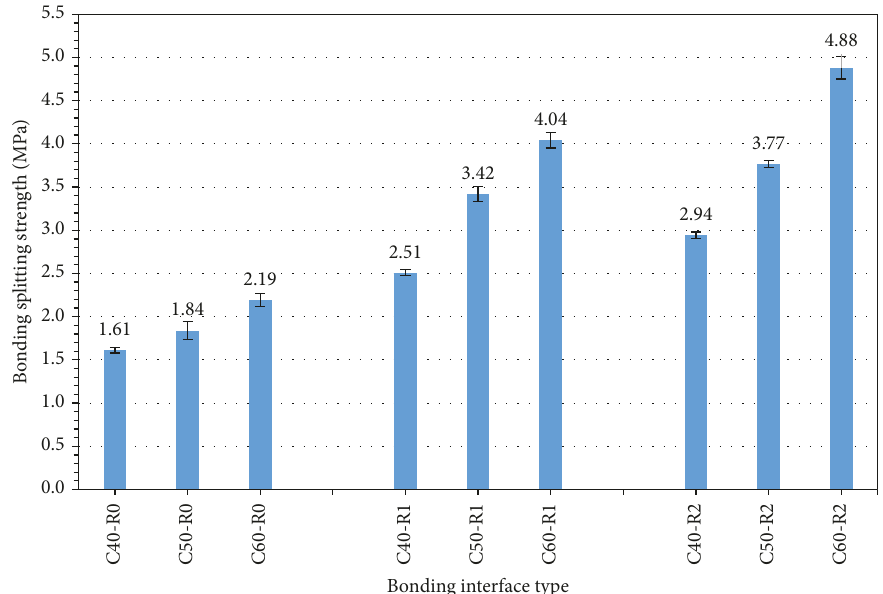
Figure 25: Bond splitting strength with cement concrete of different strength